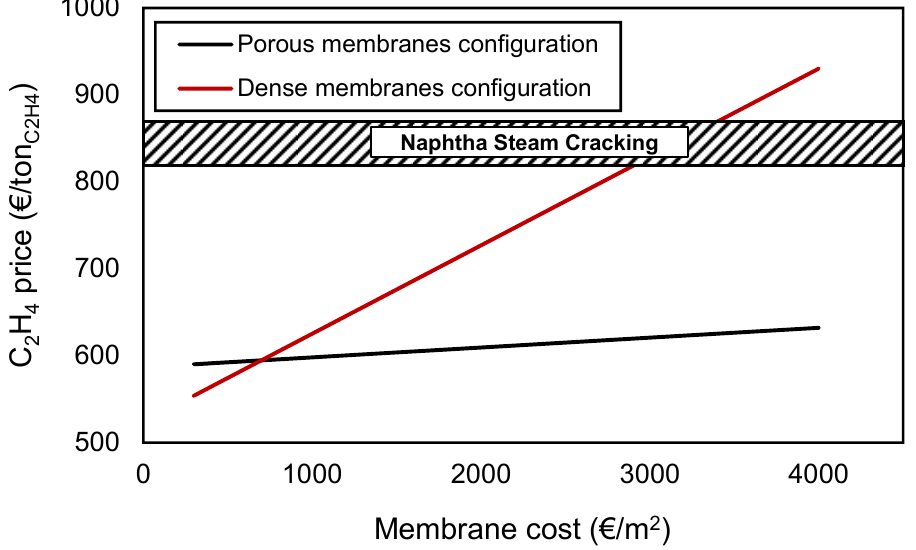
Figure 6. Calculated C 2 H 4 price for the OCM porous and dense membrane reactor configurations when changing the cost of the membranes (in € / m 2 ) and C 2 H 4 price achieved with the conventional naphtha steam cracking (NSC).